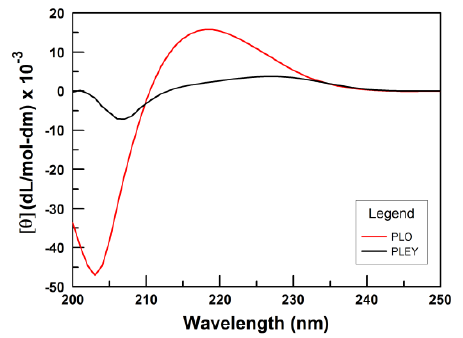
Figure 1. Far-UV dichroic spectra of polymers in water. Poly(ornithine) (red), poly(glutamic acid, tyrosine) (black). The polymer concentration, 0.02 mg/mL in each case, was ca . 2000× lower than for